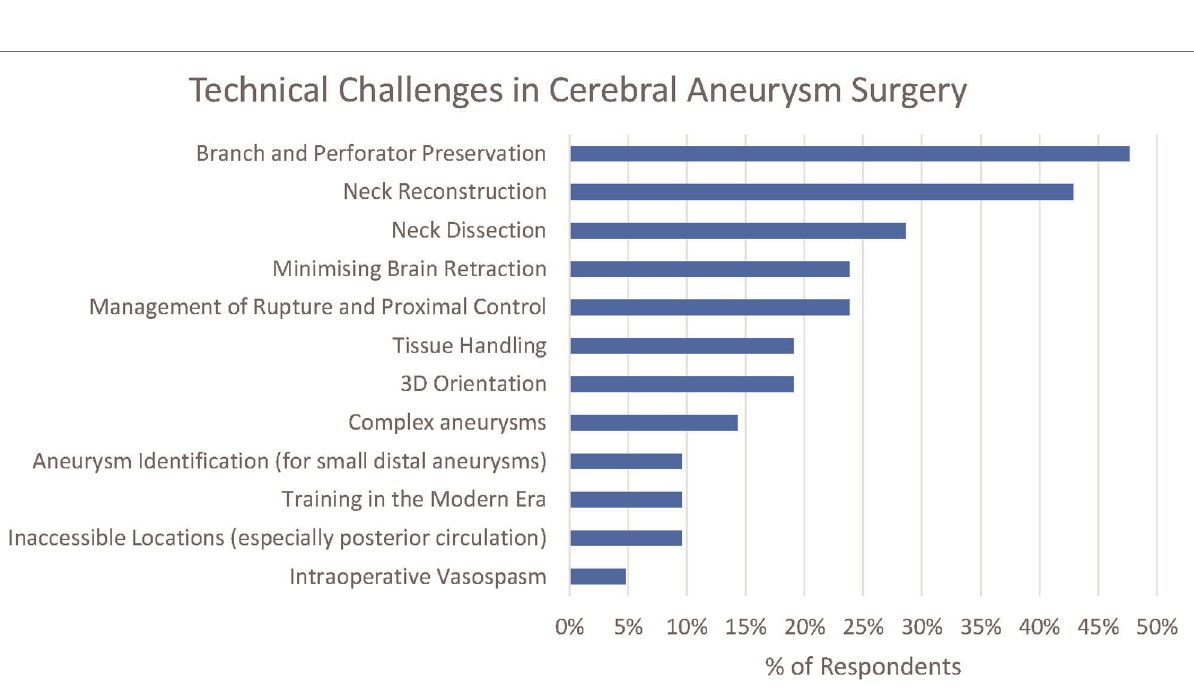
FIGURE 3 Themes and subthemes identi fi ed in technical challenges in cerebral aneurysm surgery (here, the theme of “ optimising clip placement ” is presented in its three subthemes).